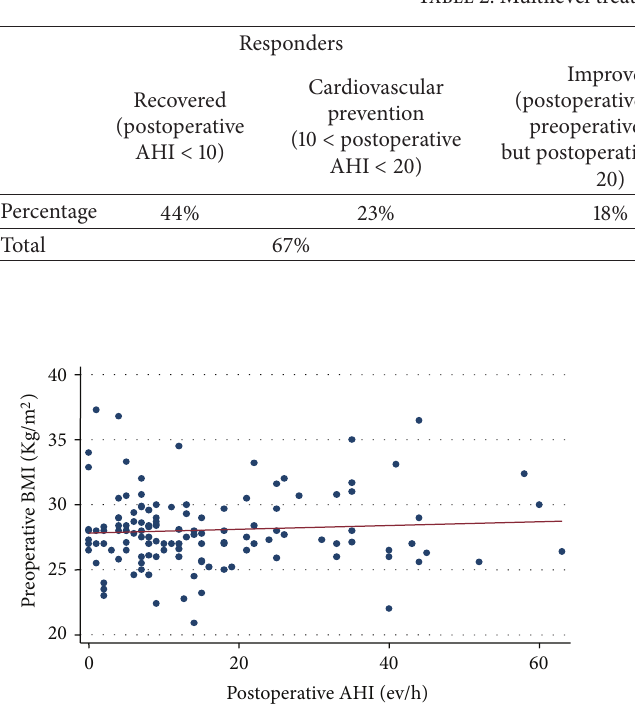
Table 2: Multilevel treatment response rates.